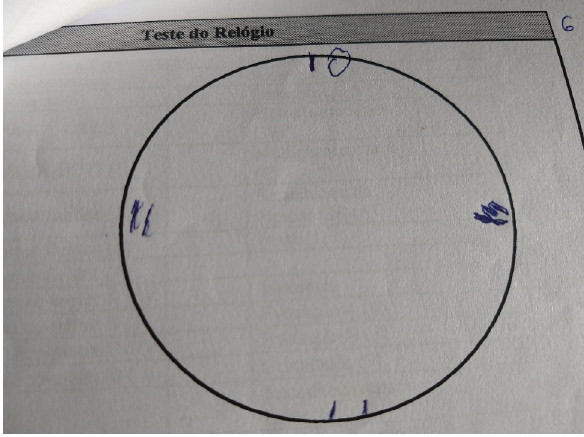
Figure 3. JS’s clock drawing test, showing severe visuospatial and executive functioning